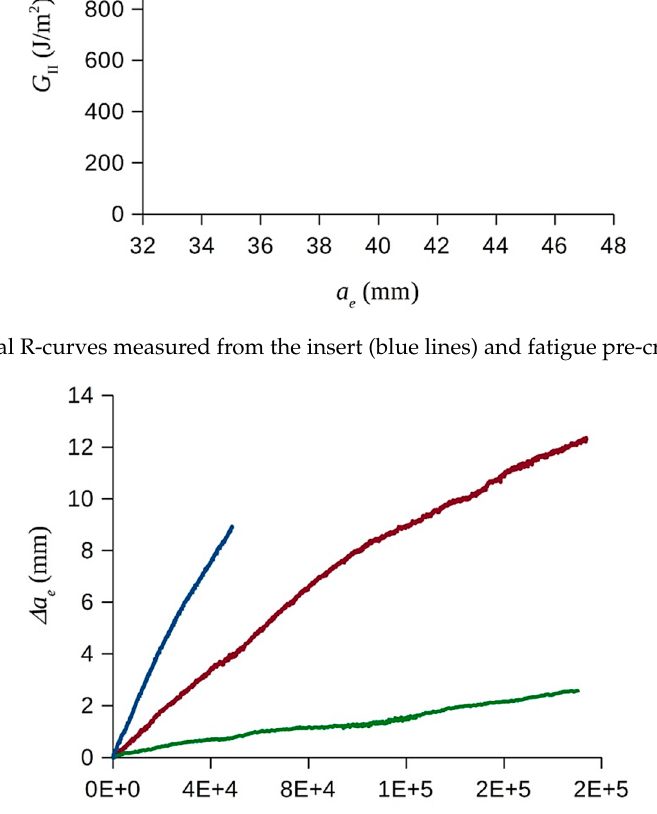
Figure 6. Typical R-curves measured from the insert (blue lines) and fatigue pre-crack (red lines).